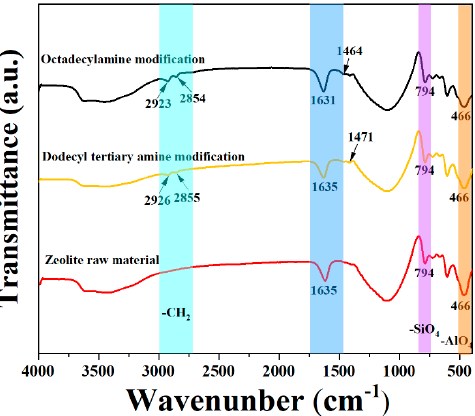
Figure 5. Comparison of infrared spectra of natural zeolite and organic amine modified